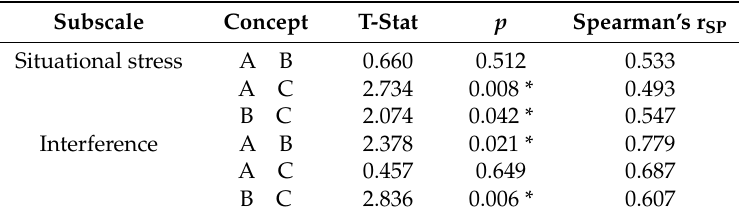
Table 6. Inferential statistics of situational stress and interference scale with Connover’s post-hoc test and Spearman’s